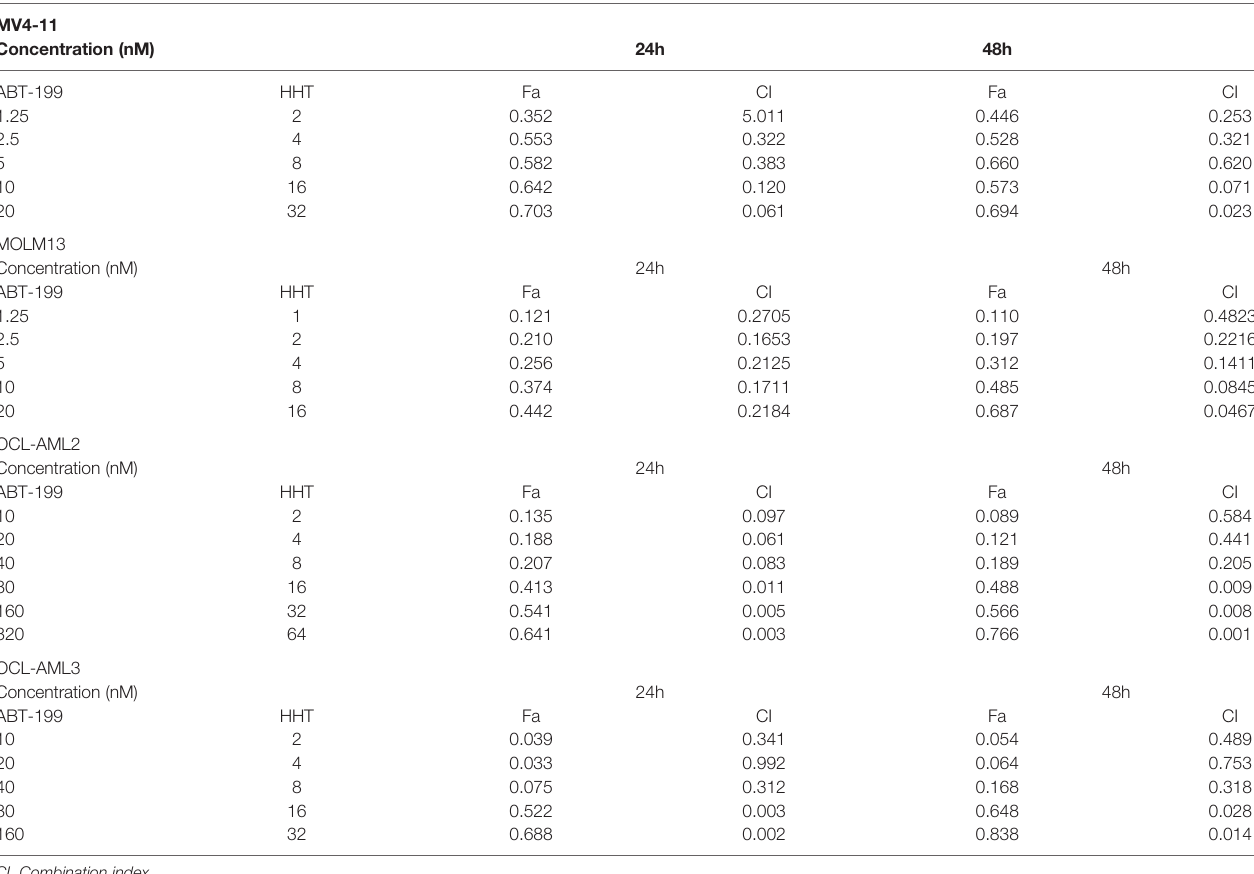
TABLE 2 | The effect of synergistic inhibition in AML cell lines. MV4-11 Concentration (nM)